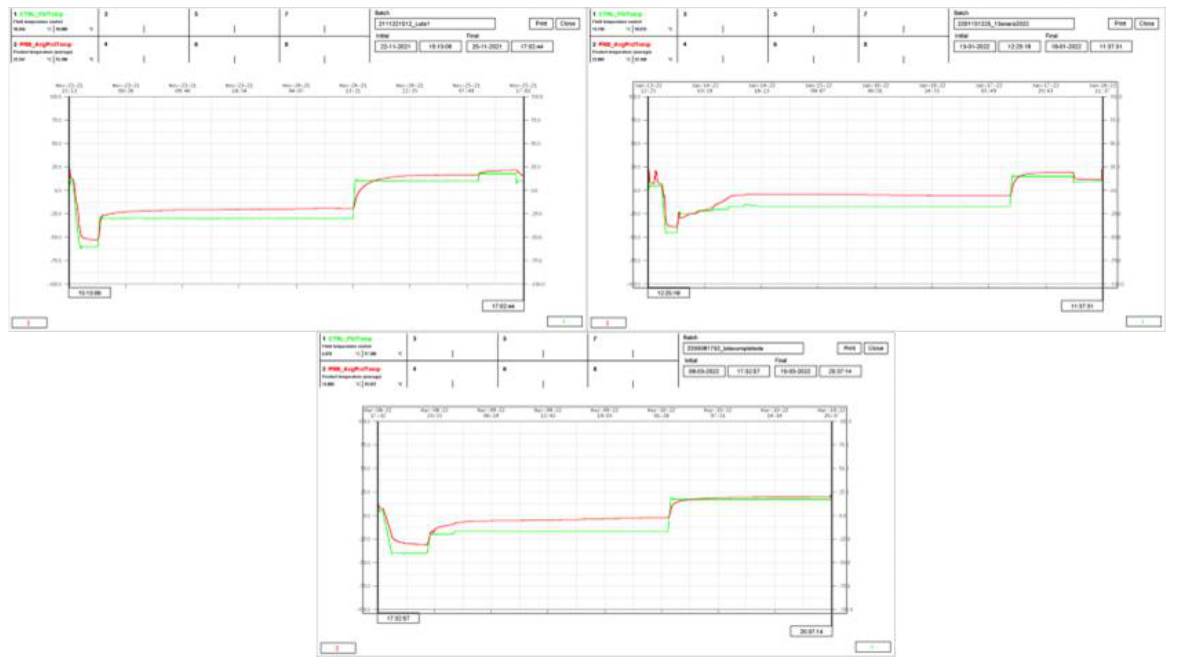
Figure 5. Temperature ramps corresponding to three lyophilization cycles. Green for fluid temperature and red for product temperature.